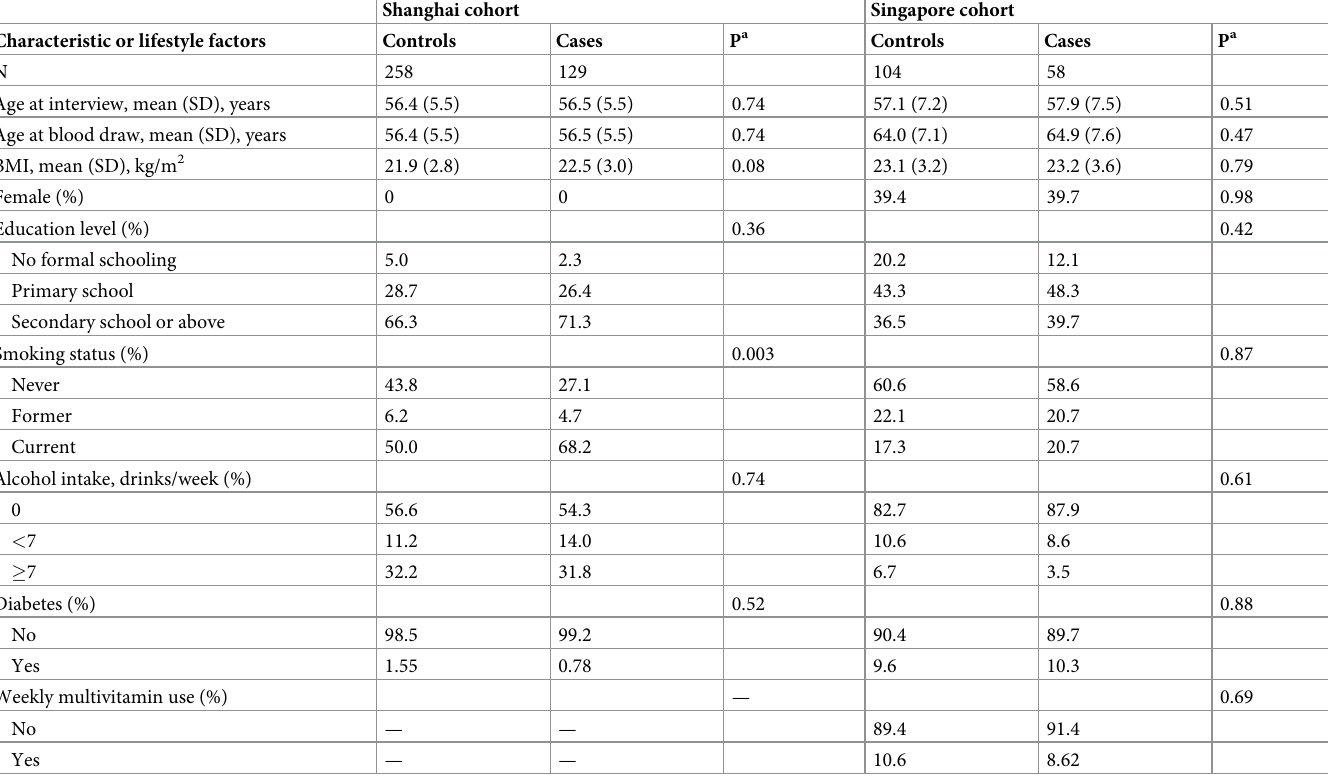
Table 1. Baseline demographic characteristics and lifestyle factors in pancreatic cancer cases and control subjects, the Shanghai Cohort Study and the Singapore Chinese Health Study. Shanghai cohort Singapore cohort Characteristic or lifestyle factors Controls Cases P a Controls Cases P a